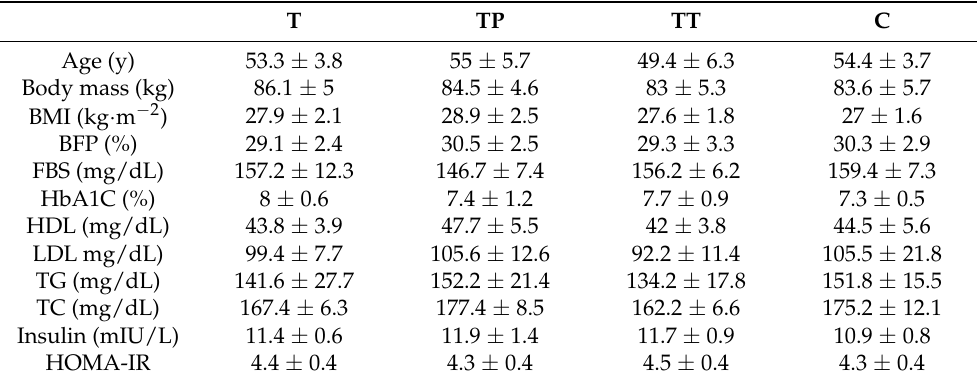
Table 1. Descriptive characteristics of participants (mean ±